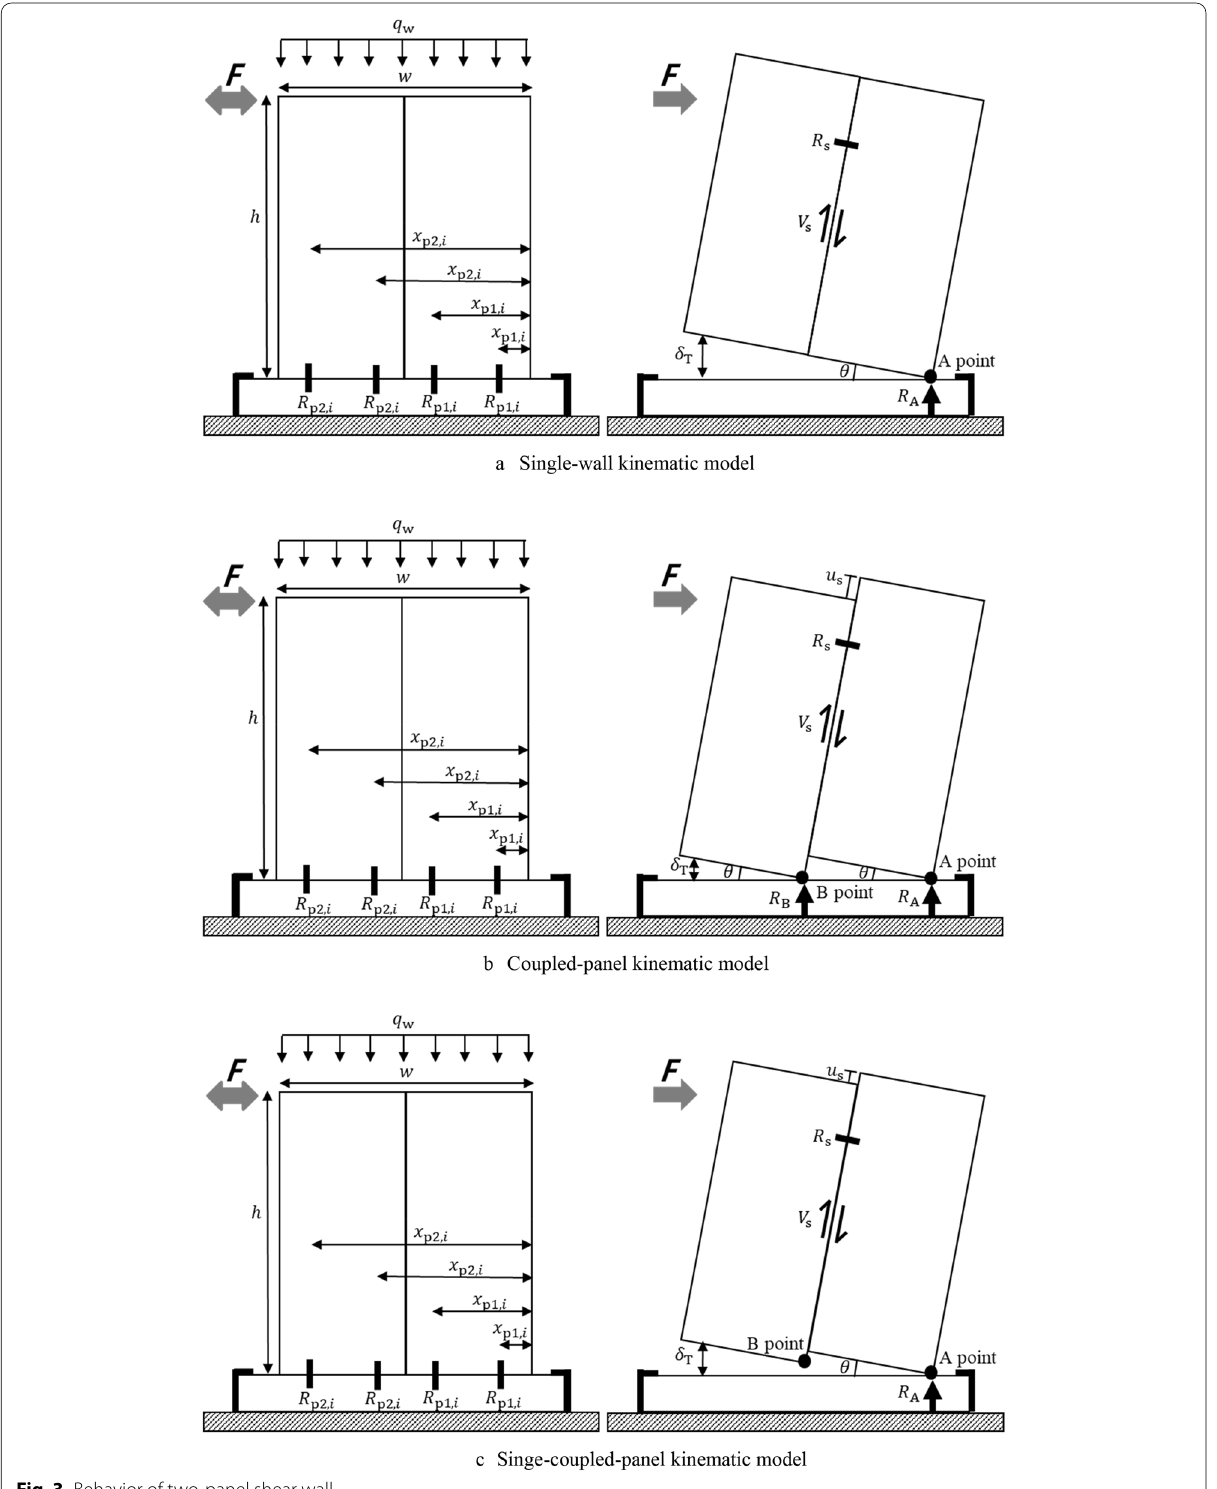
Fig. 3 Behavior of two‑panel shear